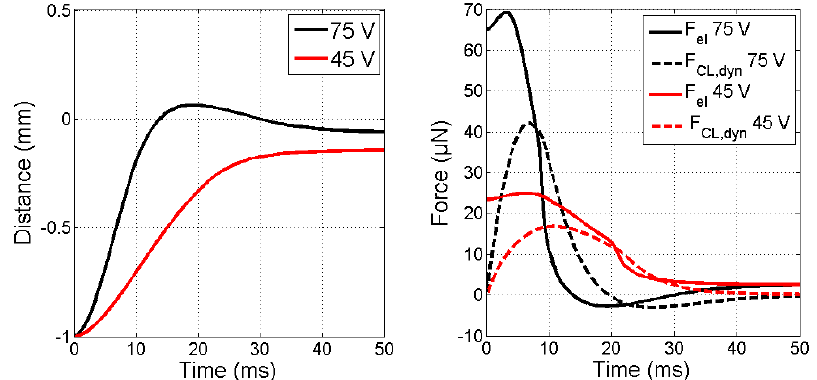
Figure 7. Results of the dynamic droplet position model for the parameters listed in Table 1 for the parallel plate test case for actuation voltages of 45 V and 75